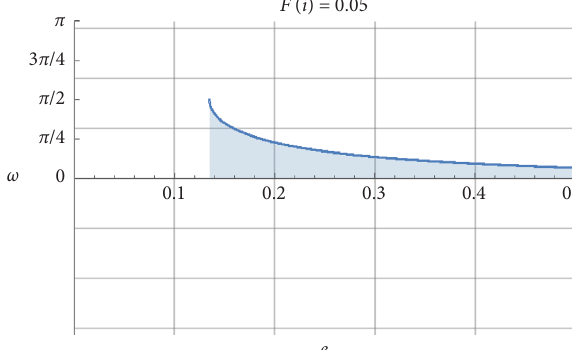
Figure 5: The curve ω ( e ) at which _ e � _ i � 0 for F ( i ) � 0.05.